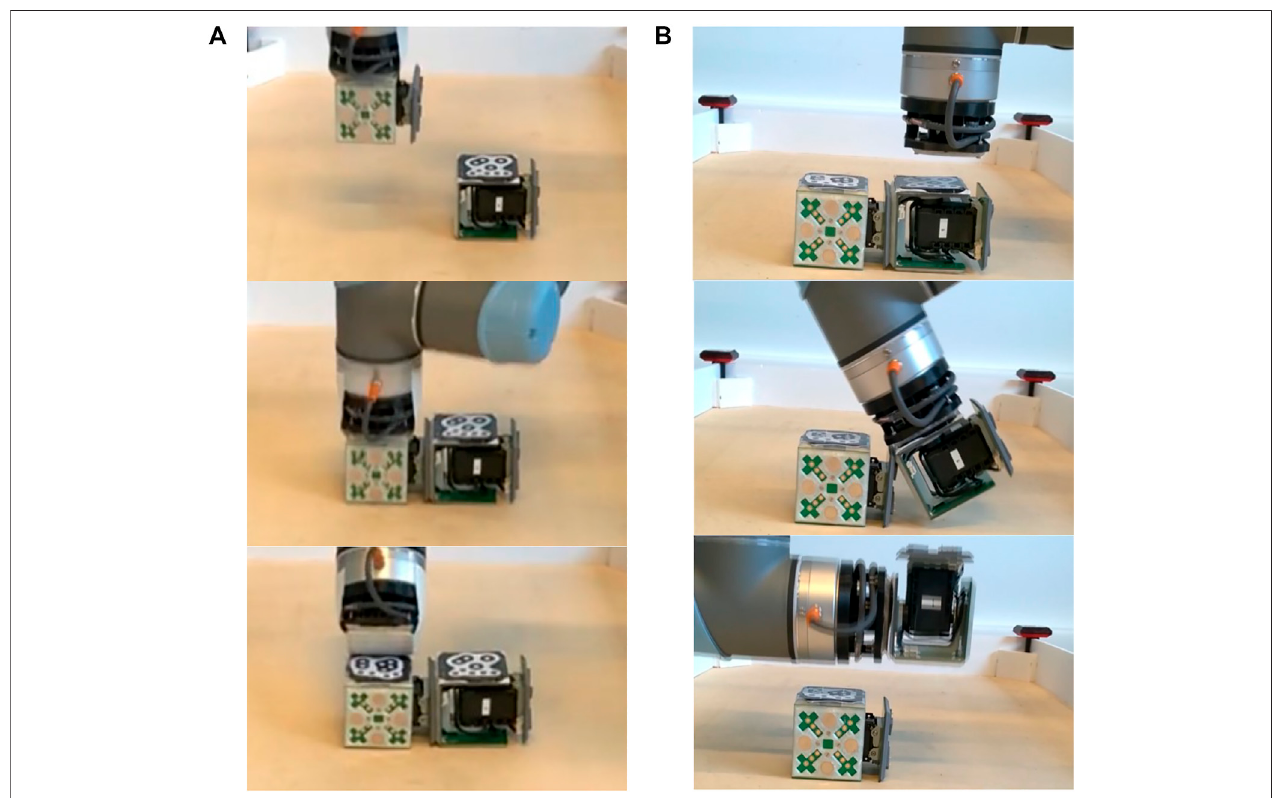
FIGURE11| AutomaticreconfigurationoftheEMERGEmodules (A) Attachmentofamoduletoanothermodulebyusingapassivegripperandsubsequentrelease (B) Detachment of a module from a morphology using an arc-like movement.